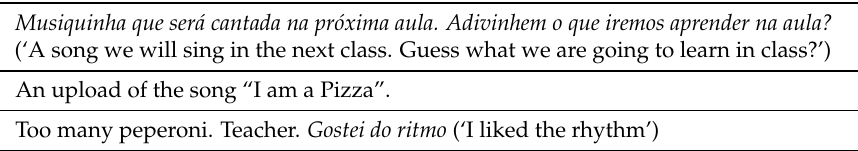
Table 3. Transcript 3: Song posted on Facebook—“English for Us” closed